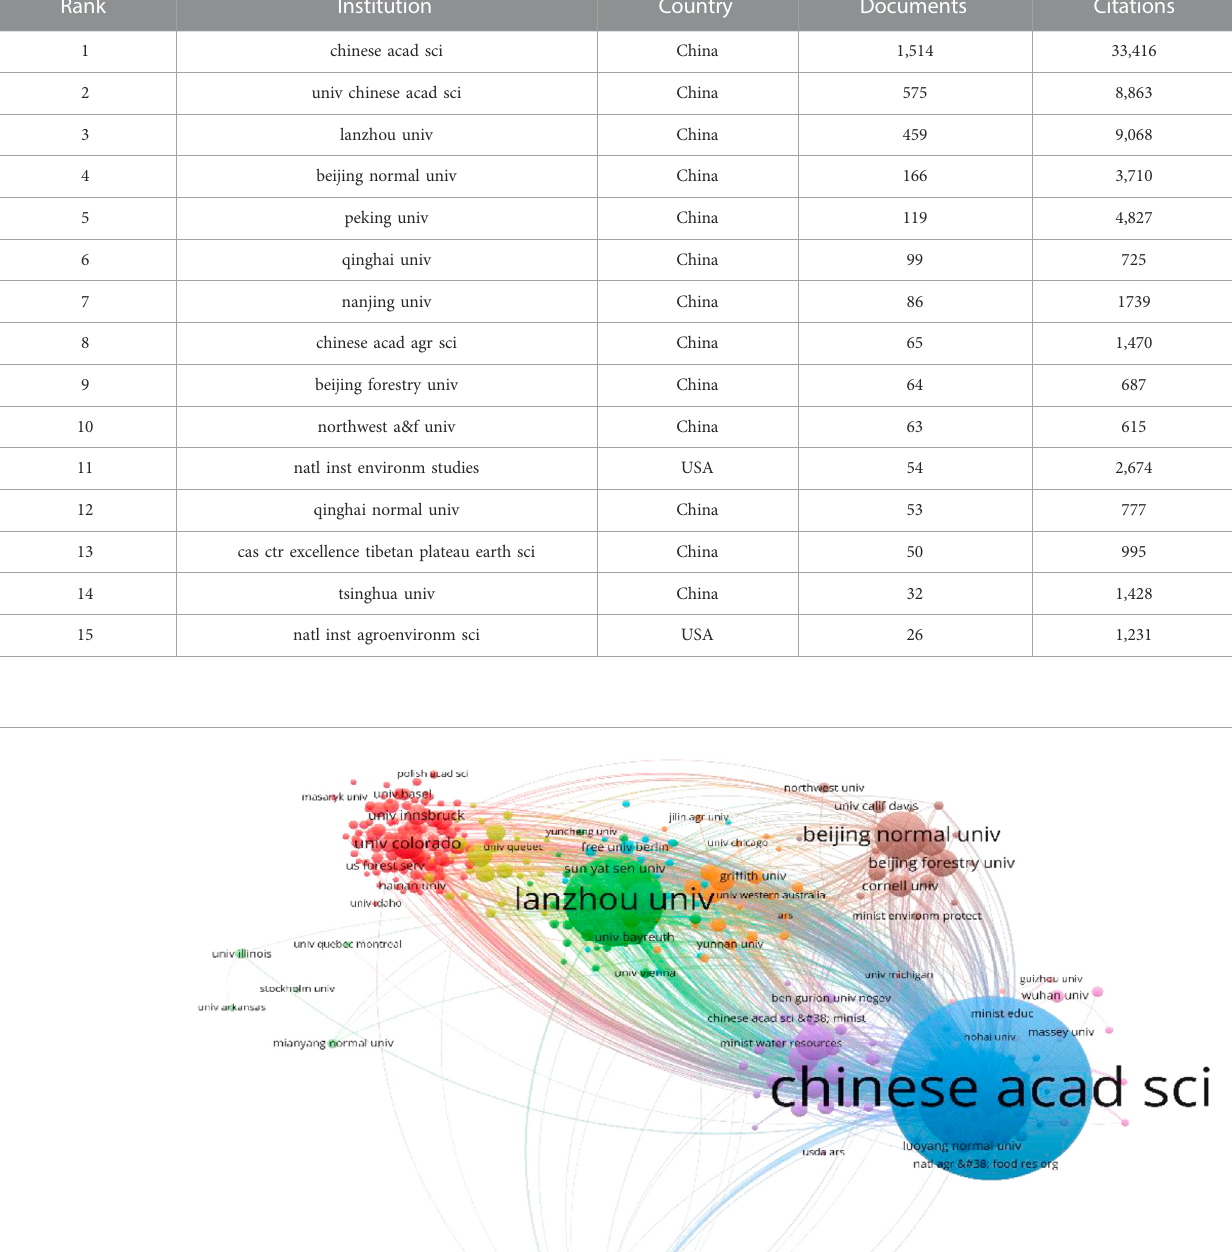
TABLE 2 Top 15 ranking of scienti fi c institutions in the fi eld of alpine meadow research in terms of number of publications. Rank Institution Country